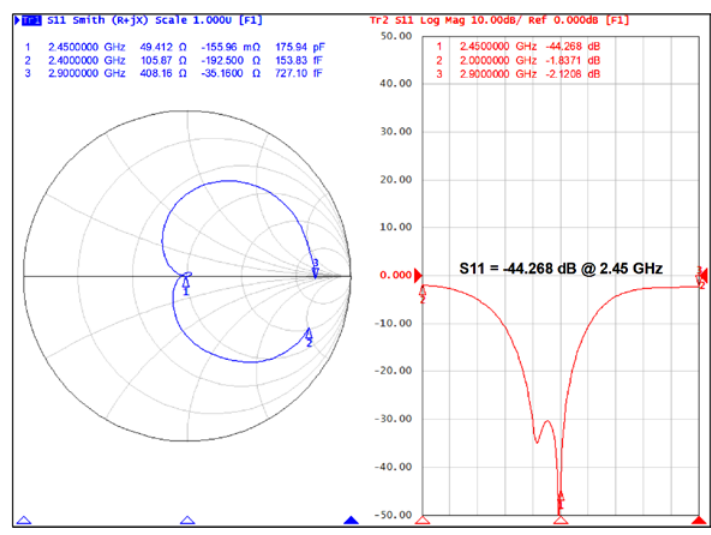
, for RF-DC converter at 5 kΩ load. |𝑆𝑆 11 |